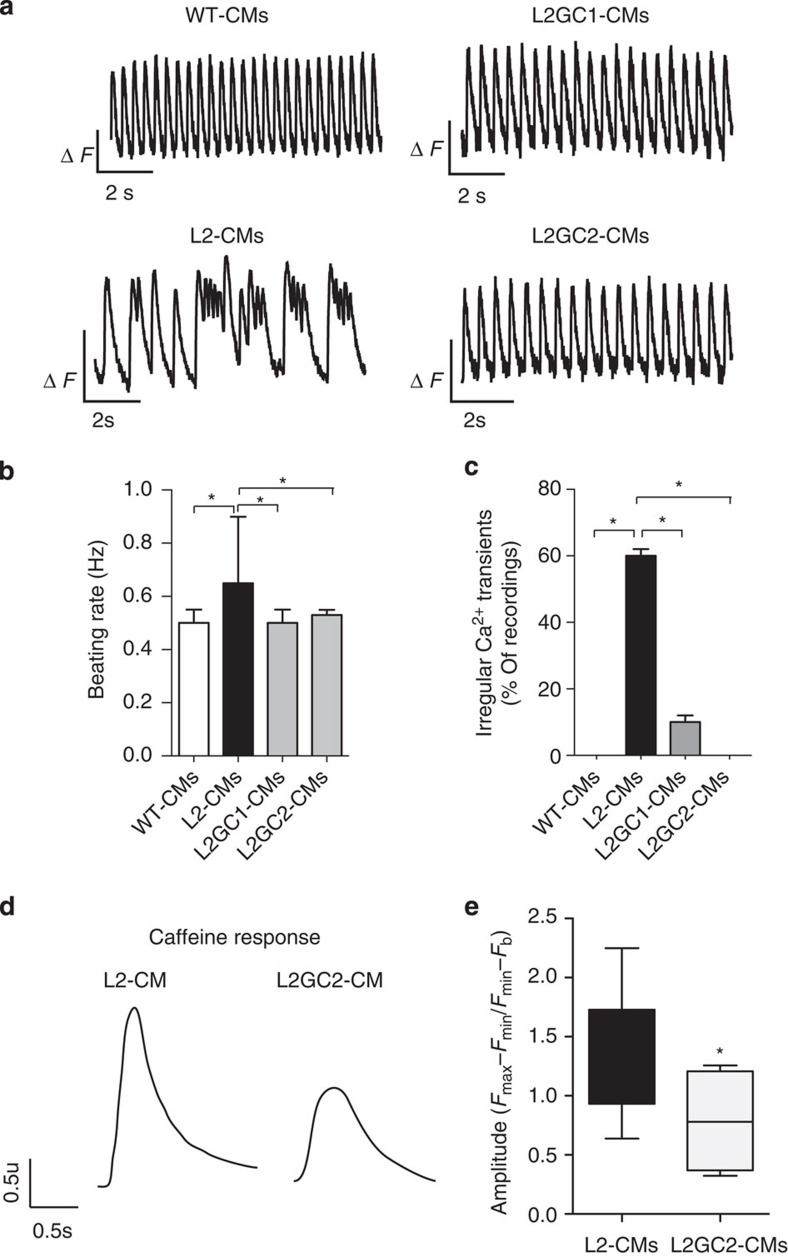
Gene correction ameliorates Ca2+ abnormalities.(a) Representative Ca2+ transients of cardiomyocytes derived from WT-, L2- and isogenic TALEN-corrected (L2GC1 and L2GC2) clones at 36 days post differentiation. (b) Beating frequency. (c) Quantification of percentages of isogenic CMs exhibiting irregular Ca2+ transients at day 36 of differentiation. The beating rate was measured as number of events (peaks) per time (sec) during a stimulation of 0.5 Hz. Irregular Ca2+ transients were determined by quantifying the percentage of beating areas exhibiting irregular Ca2+ transient. The number of irregular peaks were determined during each recording for 1 min at 0.5 Hz. Mean±s.d. (n=13 recordings of L2-CMs; n=16 recordings of L2GC1; n=40 recordings of L2GC1); *P<0.05 (ANOVA, Tukey's Multiple Comparison Test). (d) Representative caffeine-induced Ca2+ transients in single cells; (e) Amplitude analysis of caffeine-induced Ca2+ transients in single cardiomyocytes. A caffeine puff (10 mmol l−1) was applied and caffeine-induced amplitude was assessed. Values represent mean±s.e.m. (n=15 L2-CM and n=4 L2GC2-CM). *P<0.05 (unpaired student's t-test).